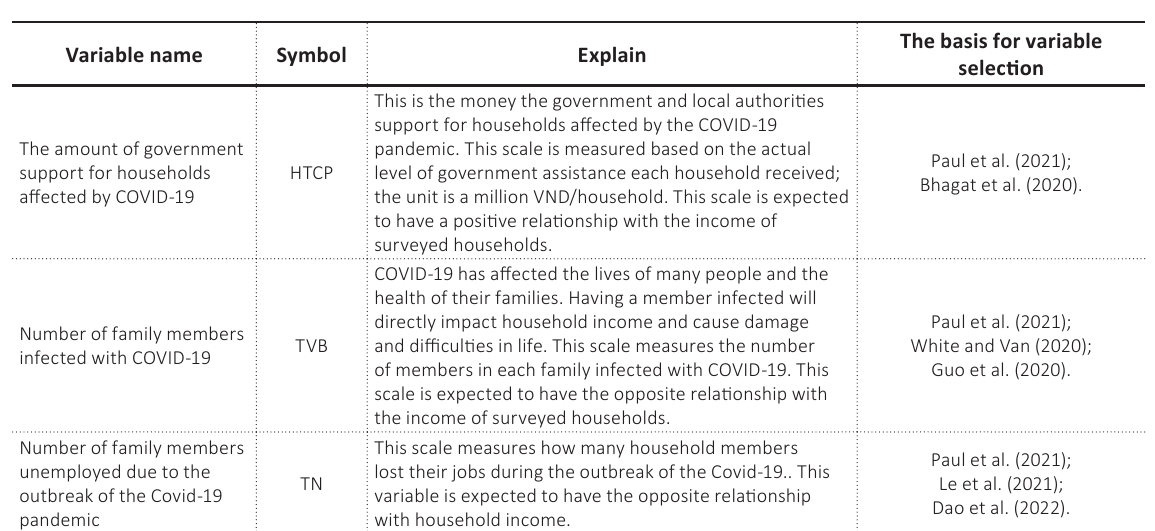
Table 1 (cont.). Variables of the model